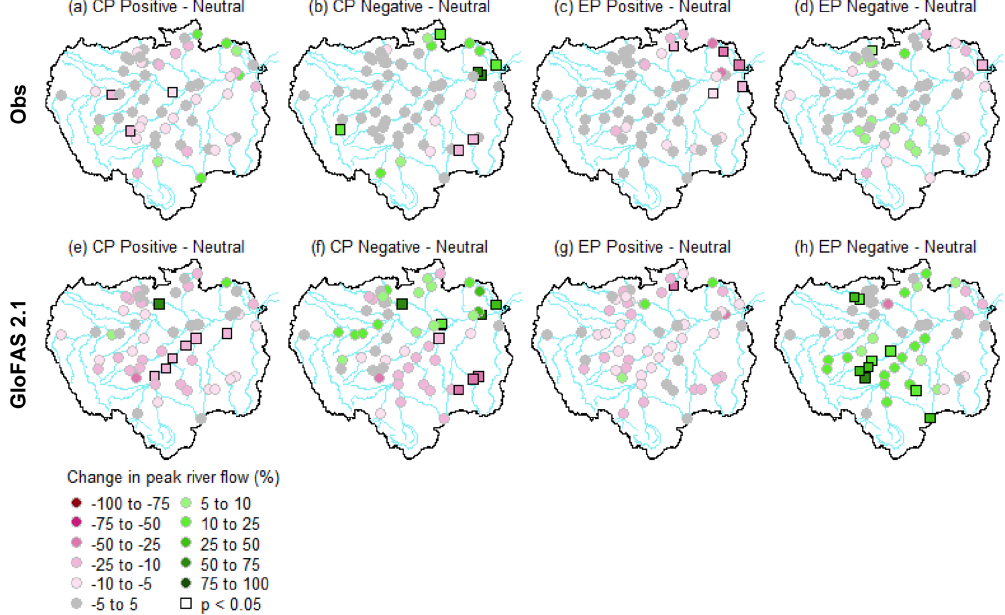
Figure 3. Percentage change of observed and simulated mean annual peak river flows between different phases of the CP and EP indices. (a, c, e, g) Positive with respect to neutral years. (b, d, f, h) Negative with respect to neutral years. Panels (a–d) represent changes for observations and panels (e–h) show changes for GloFAS 2.1 streamflow reanalysis data. Pink (green) points represent where the average annual peak flow decreases (increases). Significant results at the 95% confidence level are denoted using a square (i.e. p < 0 .